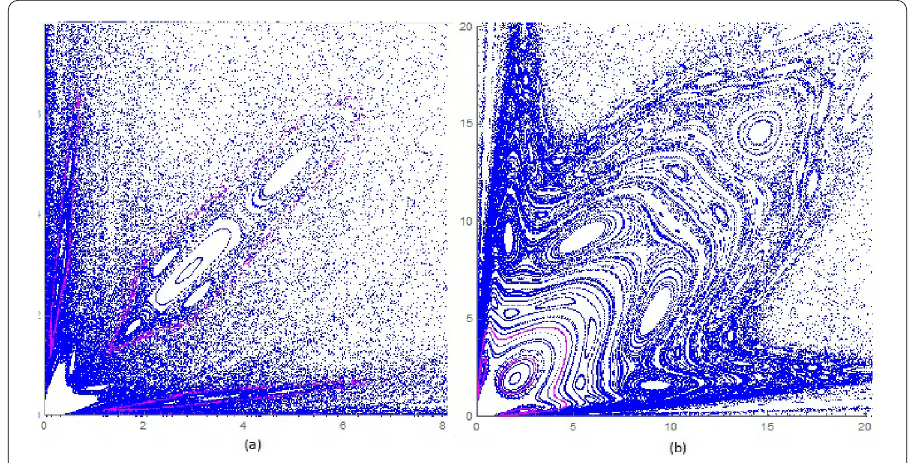
Figure 3 Some orbits of the map T associated with Eq. (20) for ( a ) a = 0.1, b = 0.002, and c = 0.001 and ( b ) a = 0.1, b = 0.02, and c =